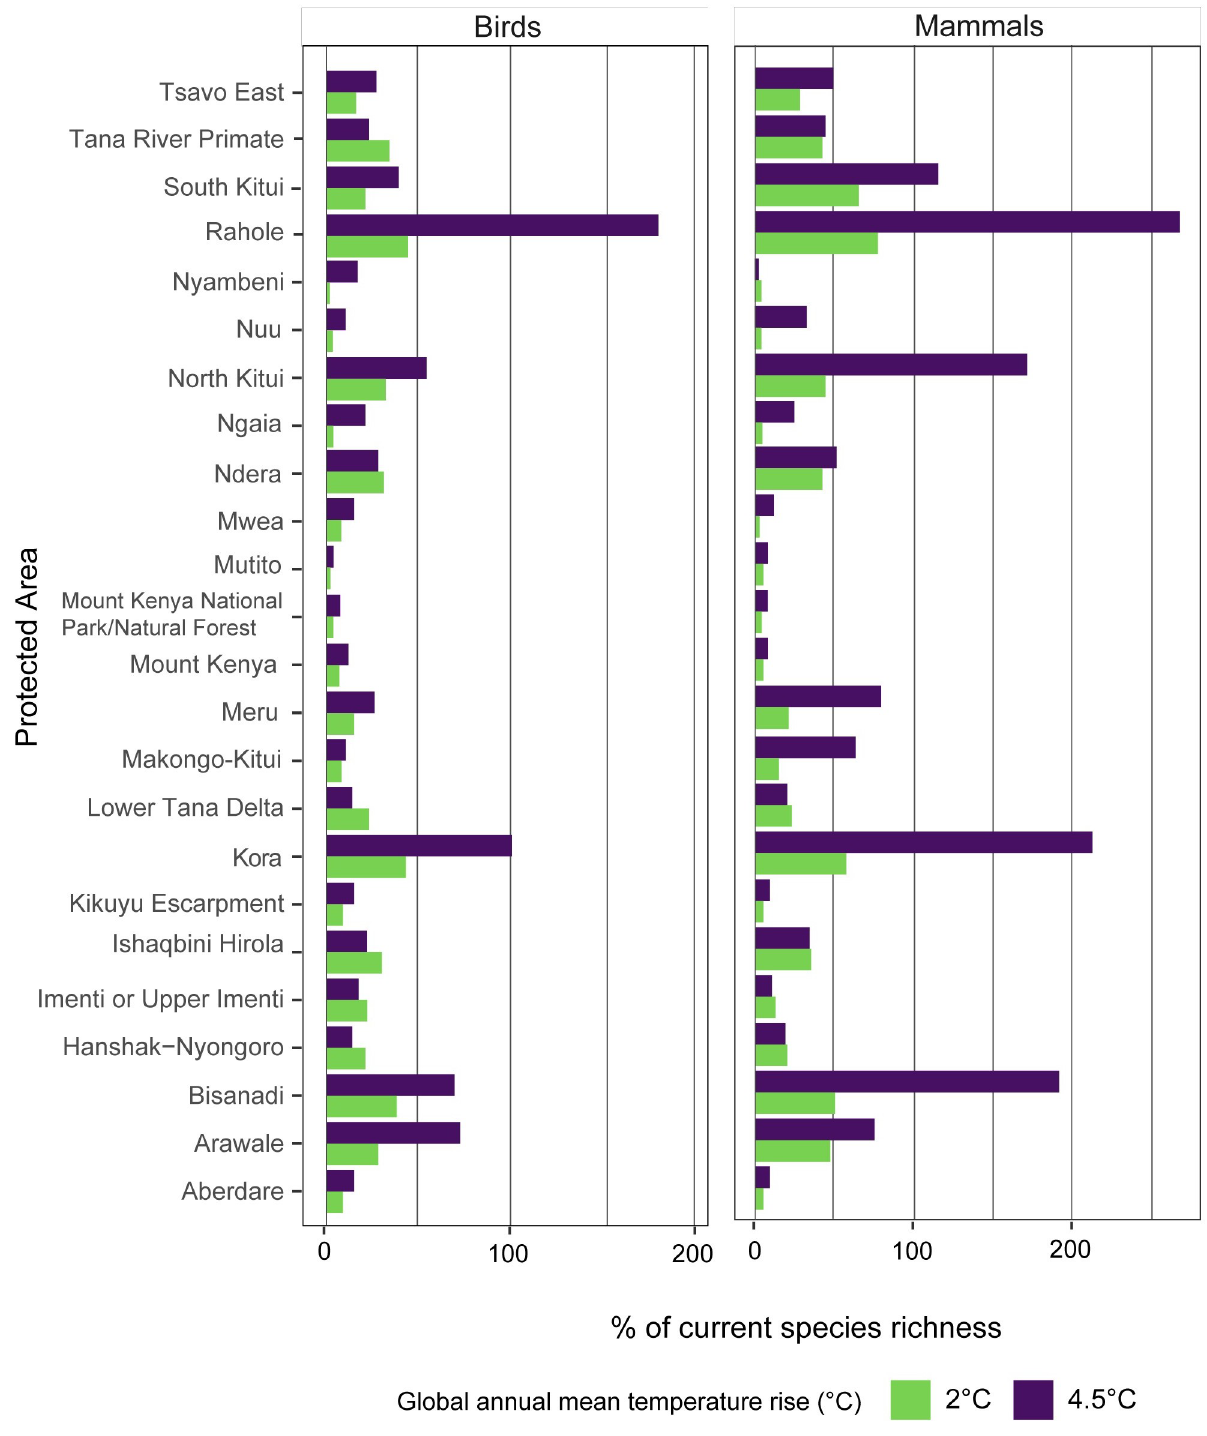
Fig 6. Additional percentage of current species richness with dispersal. This figure shows the difference between the proportion of species richness remaining in each PA without dispersal and when realistic dispersal rates are included, with 2˚C and 4.5˚C global temperature rise. Large values indicate new species have moved into the